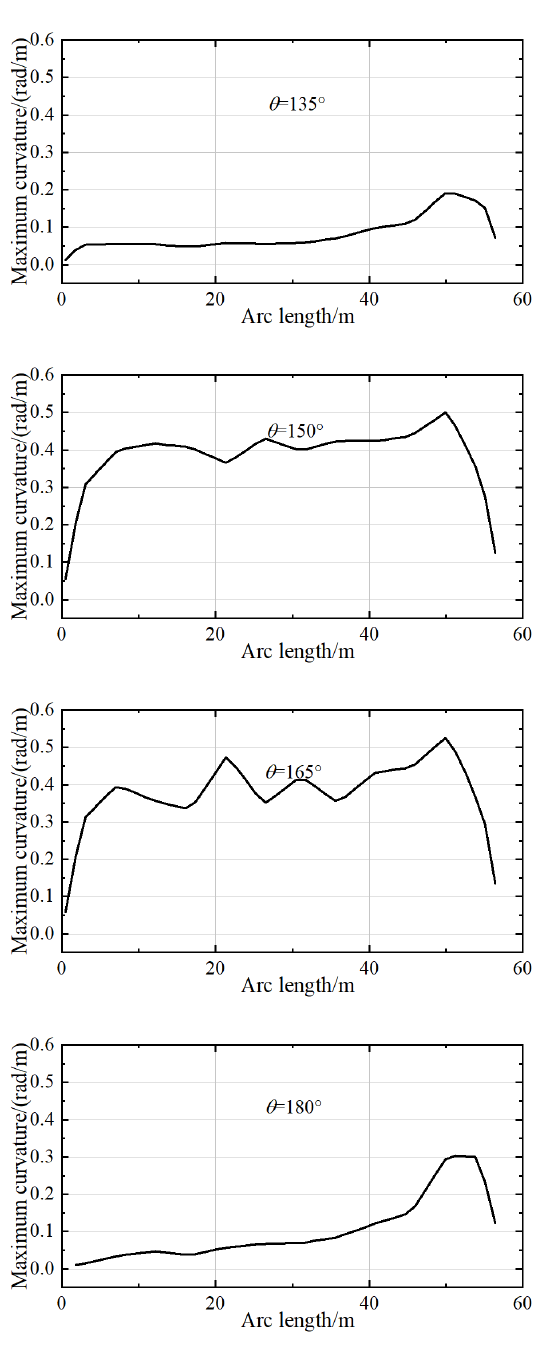
Figure 13. The maximum curvature of the crane wire along the length direction.